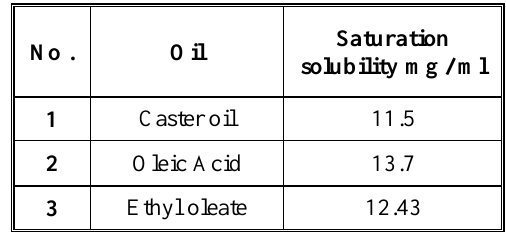
Table3. Solubility of darifenacin Hydrobro- mide in different